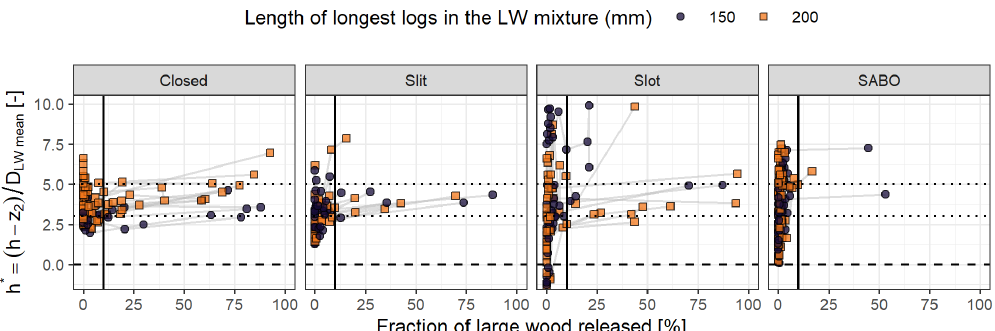
Figure 10. Percentage of LW released (i.e. mass fraction of LW released during one discharge step over total sample mass) against dimen- sionless overtopping depth h ∗ . Light grey lines connect points of each single run. The continuous vertical line marks the 10% released which was fixed arbitrarily as the threshold value for significant LW release. The most significant LW release appears for 3 < h ∗ < 5, but discharge steps with an absence of releases also appear often as illustrated by the numerous points on the left-hand side of each